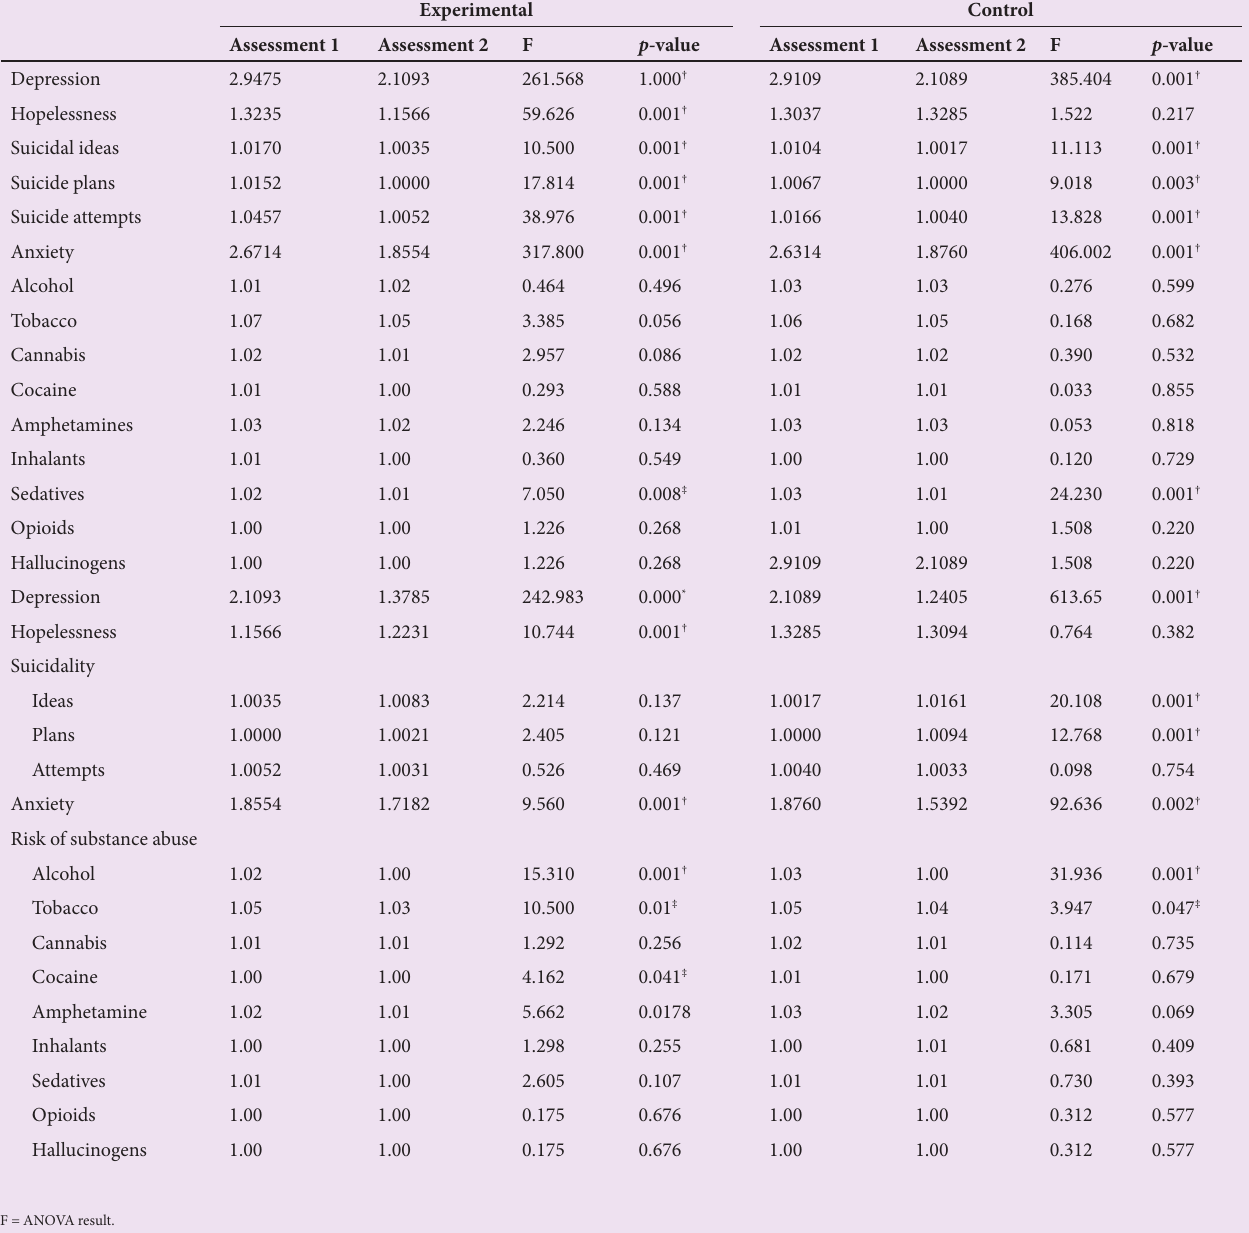
Table 5. Correlation co-efficient test on mean differences of effects of psycho-education between assessment 1 and 2 within each study